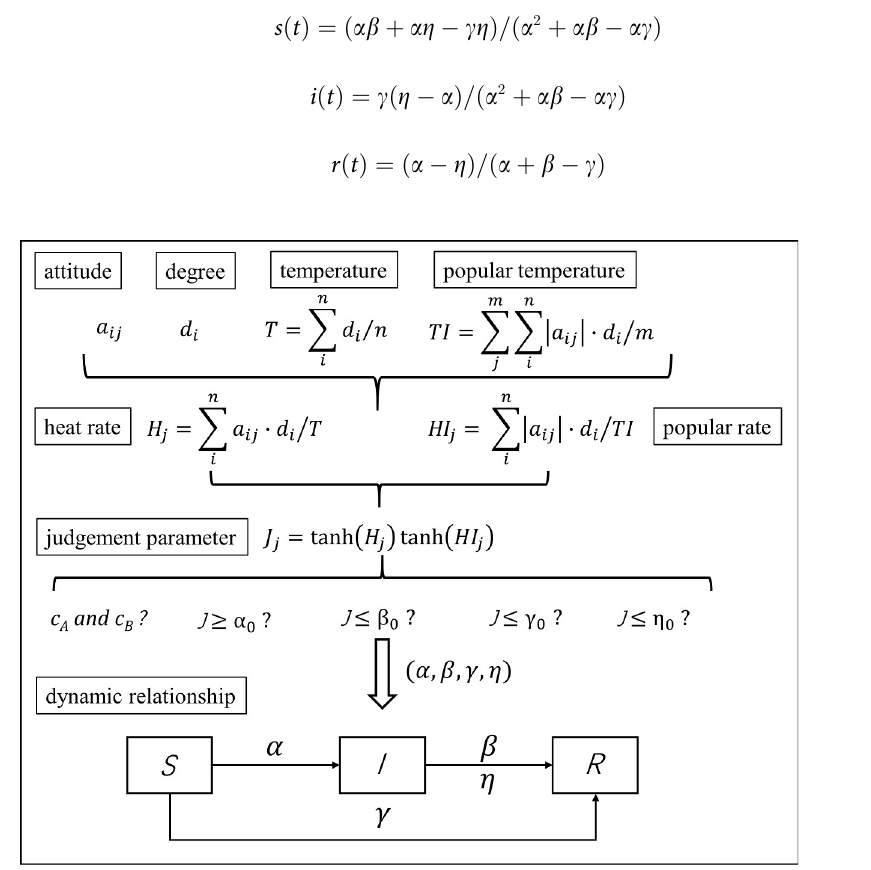
Fig 2. The transformation model and dynamic relationship between different groups of the multi-information